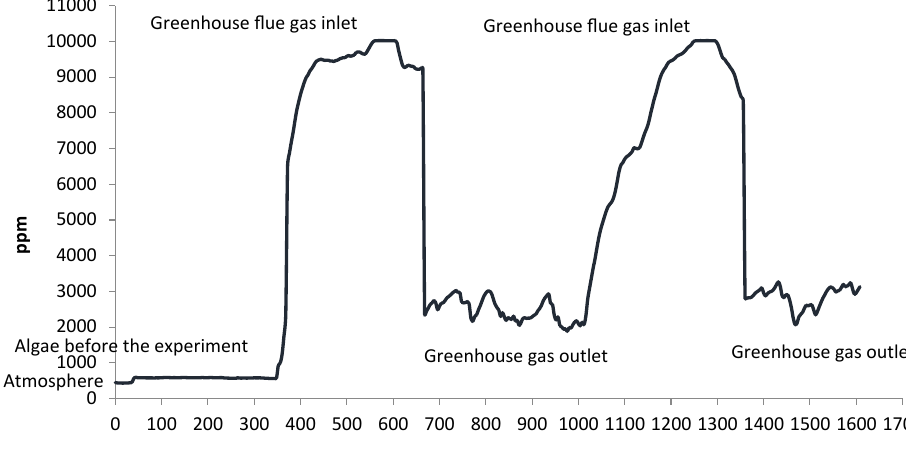
Fig. 4. CO 2 concentration monitoring throughout a GHG assimilation experiment preformed during the 22 April 2014, at the Ariel West research